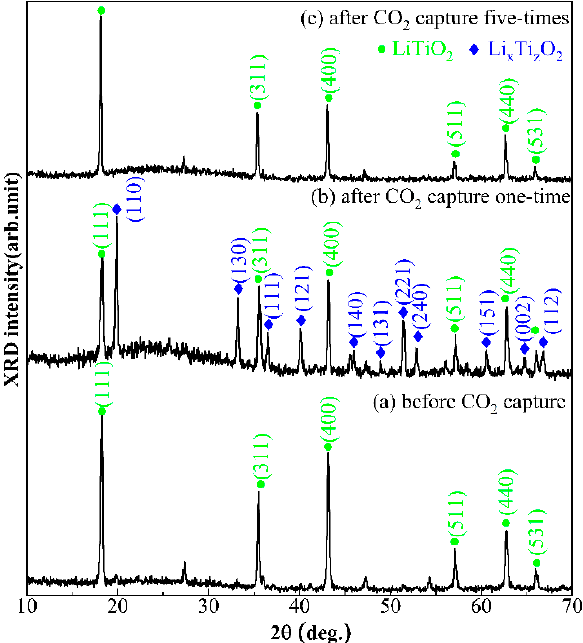
Figure 3. XRD patterns of synthetic LiTiO 2 before and after CO 2 absorption.